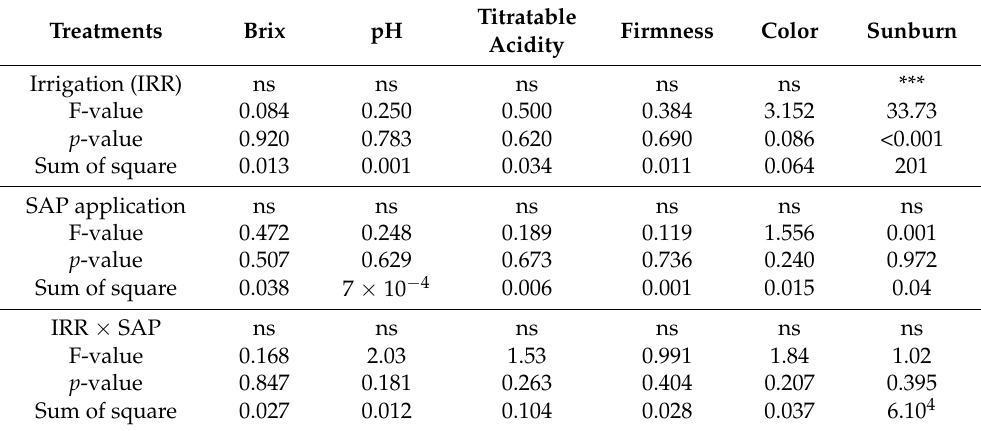
Table 2. Results of two-way ANOVA analysis on qualitative parameters of processing tomato grown under different irrigation treatments (IRR) factorially combined with the application of two levels of a superabsorbent polymer (SAP-treated and non-treated control). Results of interaction are also reported (IRR × SAP).